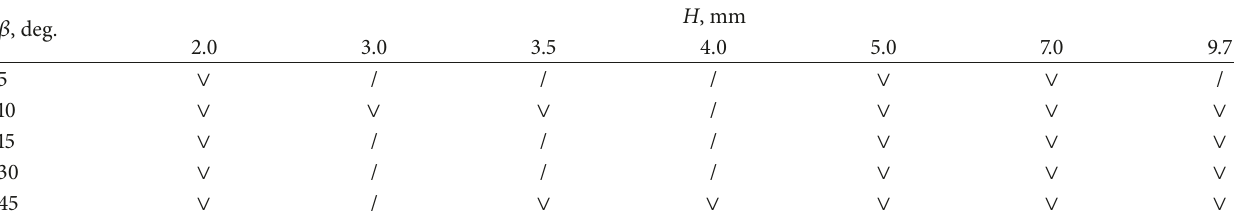
Table 1: The geometry of the yawed rectangular